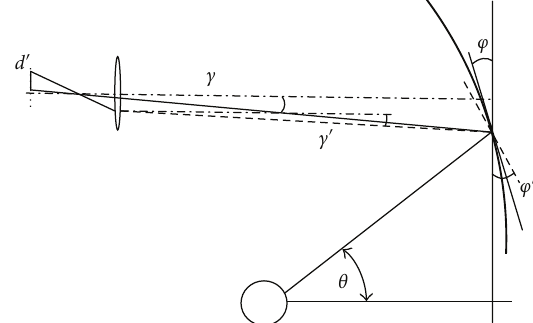
Figure 6: Detail of the reflector, schematically introducing a slope